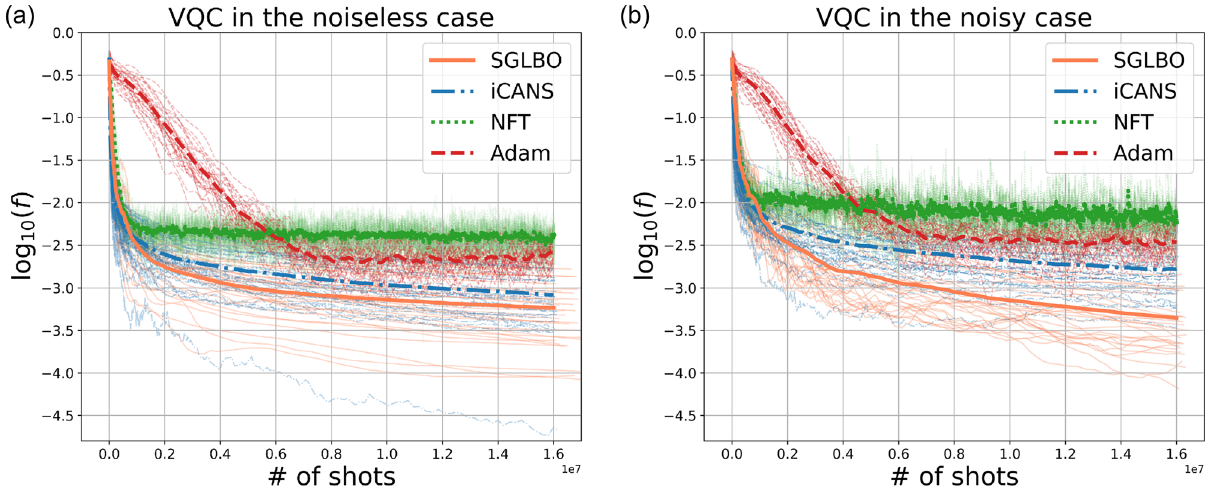
Fig. 4 Comparison of optimizers in terms of the performance on VQC tasks. We optimize the cost function of the VQC task a without hardware noise and b with hardware noise for the ansatz circuit in Fig. 2 with n = 4 qubits and r = 6 repetitions. In both plots, x -axis represents the total number of measurement shots used during the optimization, and y -axis represents the cost-function value. For each optimizer, the thin lines represent each run repeated twice from fi fteen different initial points, and the thick line represents the average of these thirty runs. Remarkably, even under the moderate amount of the noise explained in the main text, the SGLBO can achieve almost the same accuracy as the noiseless case, whereas the achievable accuracy of the other state-of-the-art optimizers becomes worse in the noisy